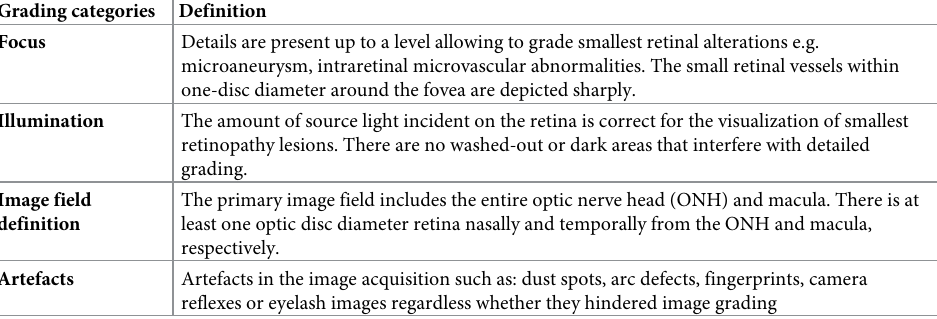
Table 1. Image quality grading criteria. Image quality was determined based on four relevant categories representing the standard for good quality color fundus images. All the following categories are necessary in order to grade retinopa- thy lesions in